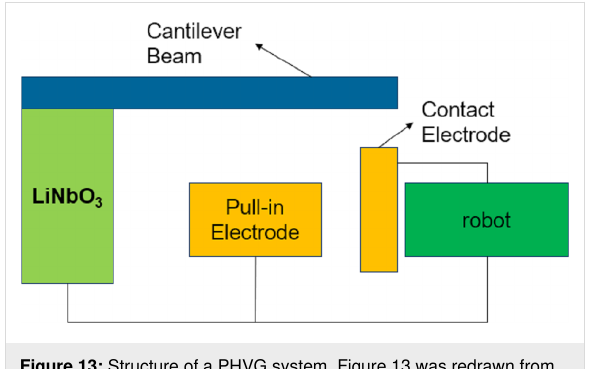
Figure 13: Structure of a PHVG system. Figure 13 was redrawn from